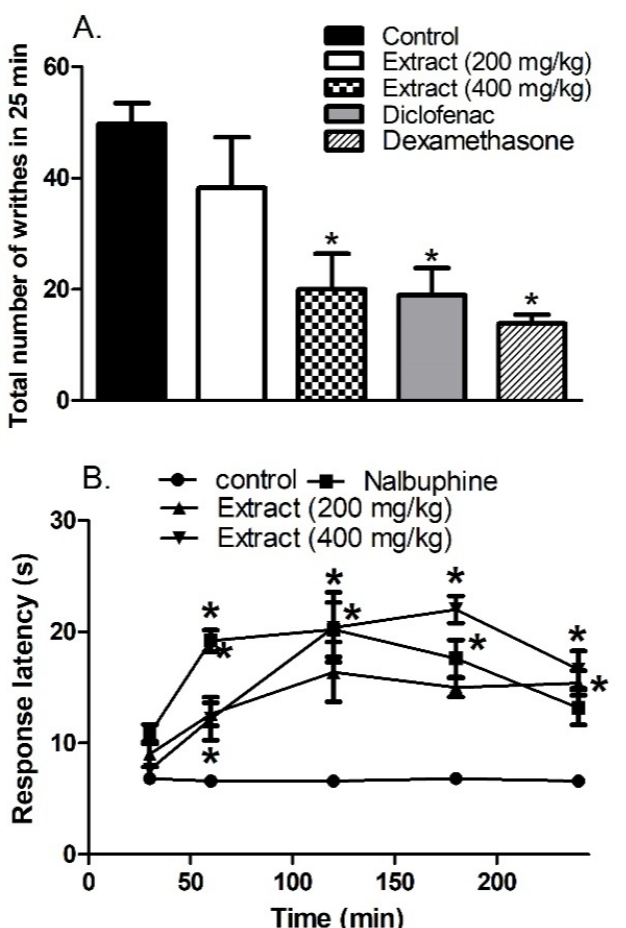
Figure 5. ( A ). Effects of H. campechianum flower extract (p.o., 200 and 400 mg/kg), diclofenac (p.o., 20 mg/kg) and dexamethasone (p.o., 2 mg/kg) on writhing induced by 0.7% acetic acid (1 mL/100g) in mice. ( B ) Response latency (s) in hot plate test measured hourly for 4 h after the vehicle, extract (p.o., 200 and 400 mg/kg) or nalbuphine (p.o., 10 mg/kg) administration in mice. Data are presented as mean values ± S.E.M. (n = 5–8). * p < 0.05 vs. control values.